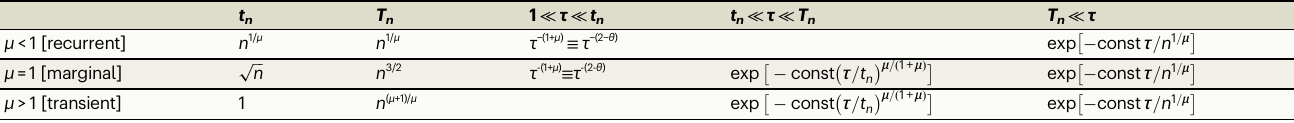
Table 1 | Summary of the time dependence of F n ( τ ) for the three classes of RWs — recurrent, marginal, and transient t